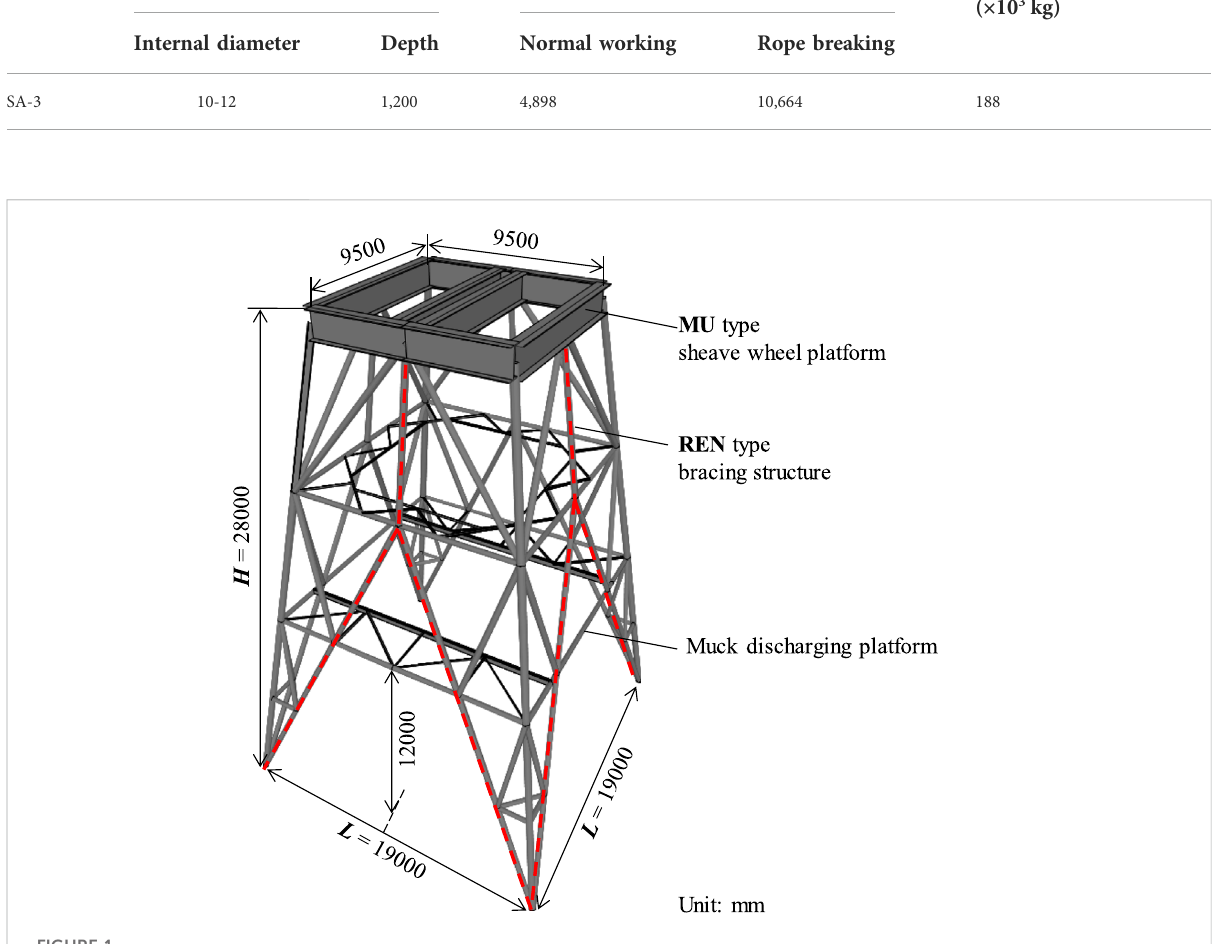
FIGURE 1 3D sketch of the SA-3 shafts sinking